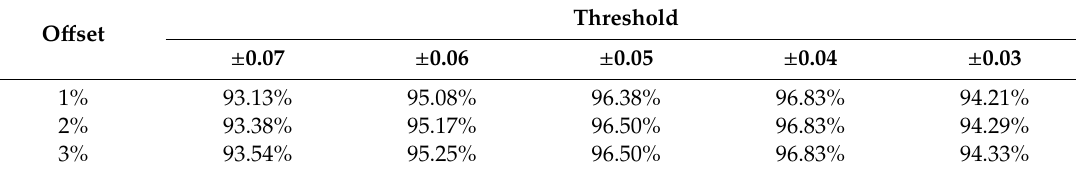
Table 6. Averaged detection probabilities of proposal 2 (window 2).